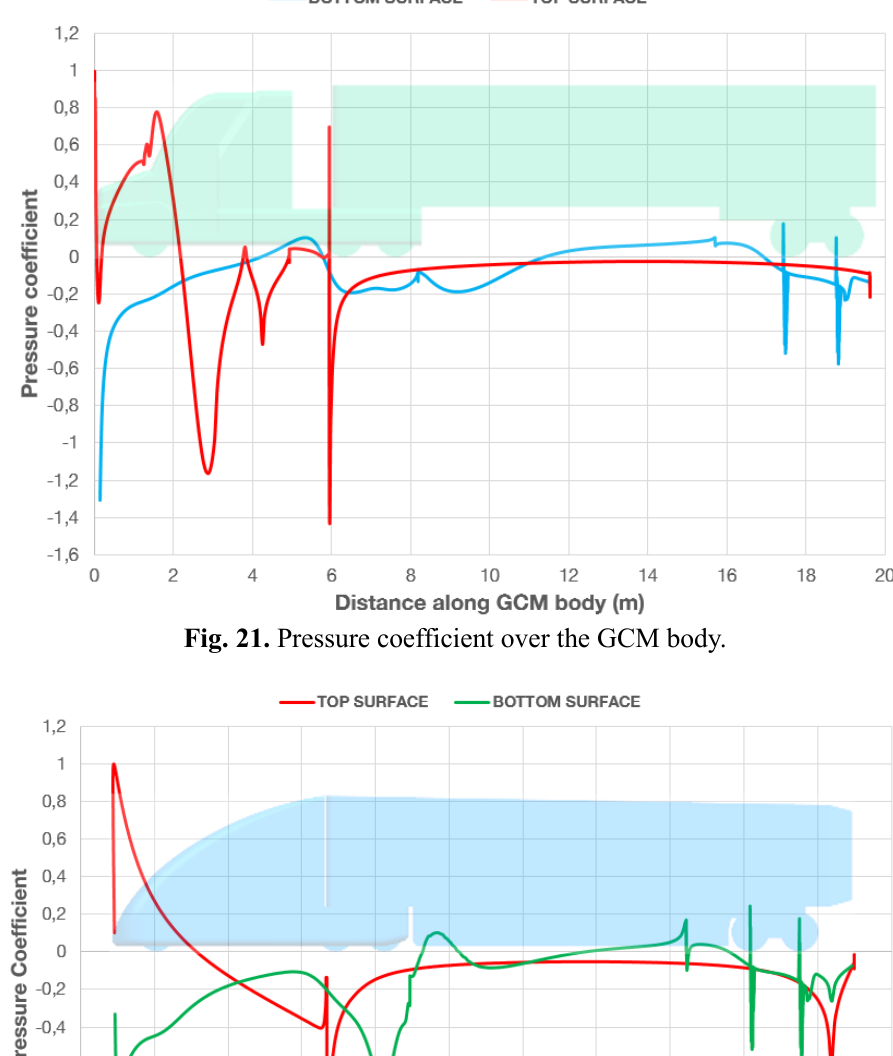
Fig. 22. Pressure coefficient over the Concept Two – Revision D